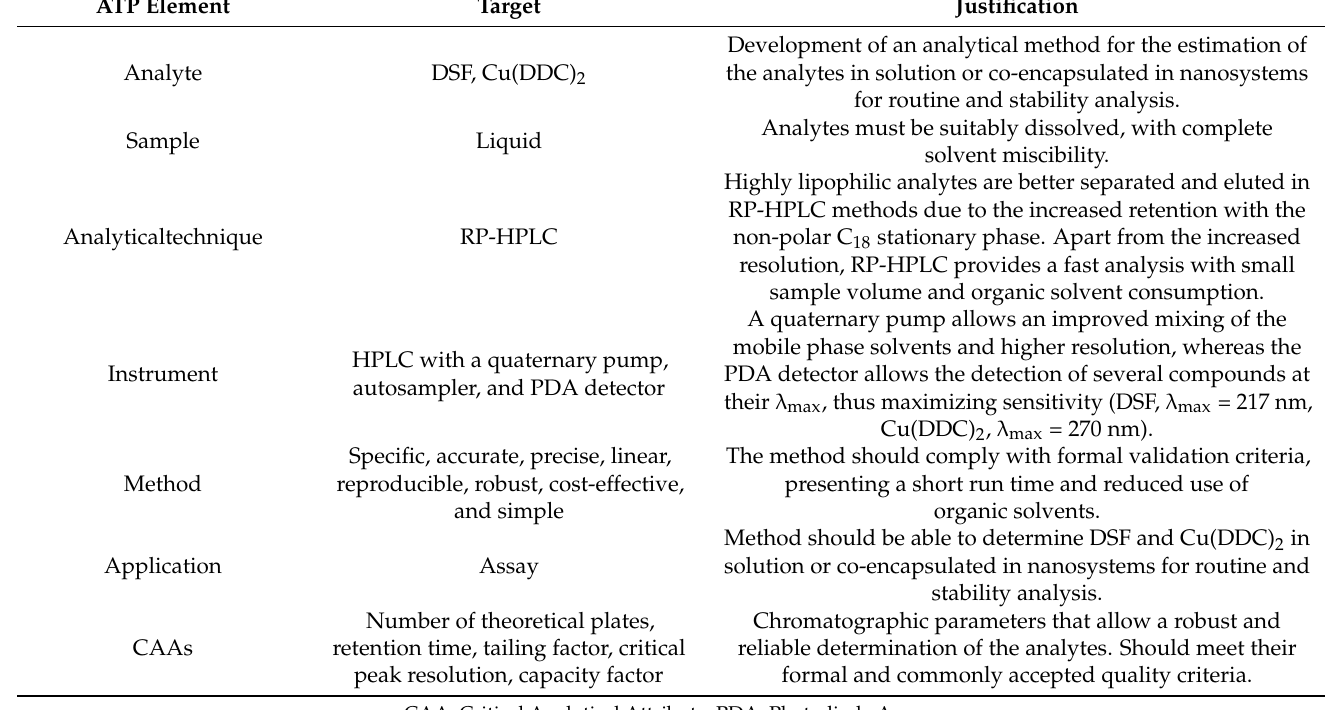
Table 1. Analytical Target Profile (ATP) postulated for the chromatographic analysis of DSF and Cu(DDC) 2 .